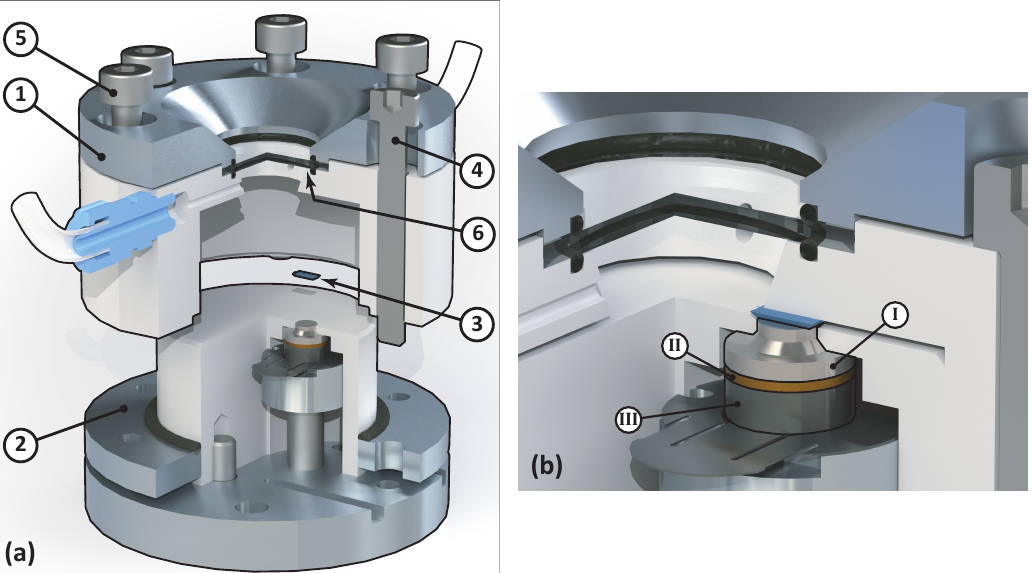
Figure 2. ( a ) Exploded cutaway view of the final design. The main parts of the design are: (1) the environment chamber top cap; (2) the environment chamber base; (3) the AFM chip; (4) the chip mounting bolts; (5) the chamber sealing bolts; and (6) the chamber window. ( b ) Cutaway view of the final design, zoomed at the actuator. The actuator consists of: (I) the acoustic horn; (II) the piezoelectric element; and (III) the back